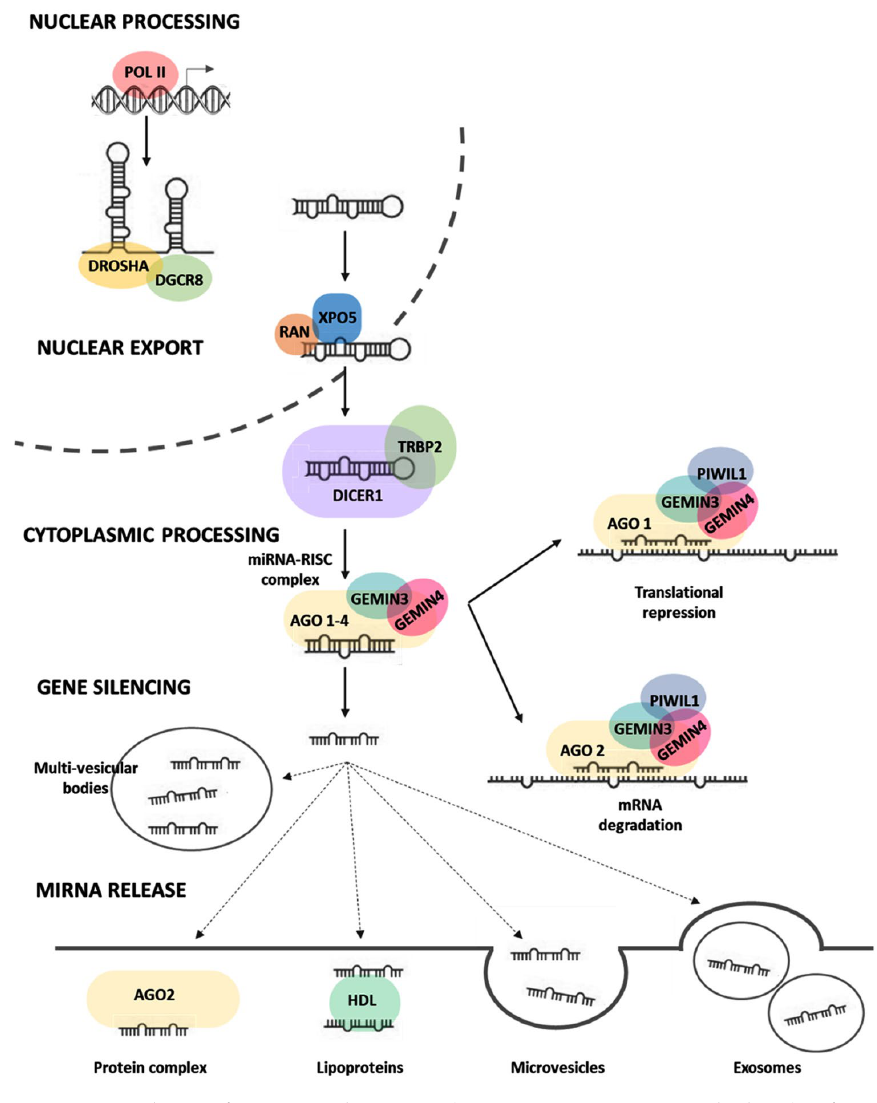
Figure 1. Regulation of microRNA biogenesis (processing, maturation, and release). After transcription of miRNA genes by polymerase II in the nucleus, primary microRNAs (pri-miRNAs) are cleaved by microprocessor DROSHA/DGCR8 complex to liberate 60–70 nucleotide hairpin-shaped precursor microRNAs (pre-miRNAs), which are then exported in the cytoplasm by XPO5/RAN/GTP complex and further cleaved by DICER1 to produce 21–24 nucleotide duplexes. One strand of the miRNA duplex can either associate with the miRNA-induced silencing complex (miRISC) and guide the binding to target mRNAs or be released by the cells. In the former case, sequence complementarity between the seed region of miRNAs and mRNAs mediates gene silencing by targeting mRNA degradation or translational repression in processing bodies (P-bodies). In the latter case, the mature miRNAs can either bind to RNA-binding proteins such as argonaute-2 or to lipoproteins, or miRNAs can be loaded in microvesicles formed by plasma membrane blebbing or in exosomes that are released in the extracellular space upon exocytic fusion of multivesicular bodies with the plasma membrane. Abbreviations: DROSHA: Drosha Ribonuclease III, DGCR8: double-stranded RNA (dsRNA)-binding protein DiGeorge syndrome critical region 8, XPO5: Exportin-5, RAN: RAN, Member RAS Oncogene Family, DICER1: Dicer 1, Ribonuclease Type III, TRABP2: Trans-Activation Responsive RNA-Binding Protein 2, AGO1/2: Protein argonaute-1 and -2, GEMIN3 or DDX20: Gem-associated protein 4 (also known as DEAD-Box Helicase 20), GEMIN4: Gem-associated protein 4; PIWIL1: Piwi-like protein 1, RISC: RNA-induced silencing complex. Figure created by Biorender.com under the license of Eman Toraih.